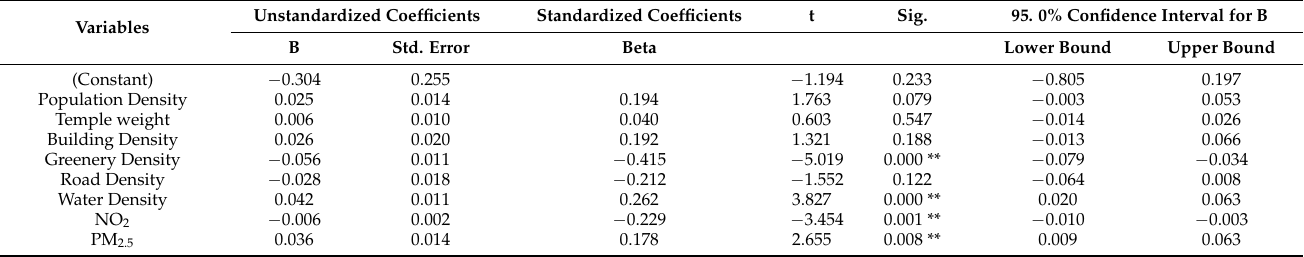
Table 7. Linear Regression Model Coefficients (greenery density, water density, NO 2, and PM 2.5 were significantly correlated with respiratory mortality at the 99% confidence